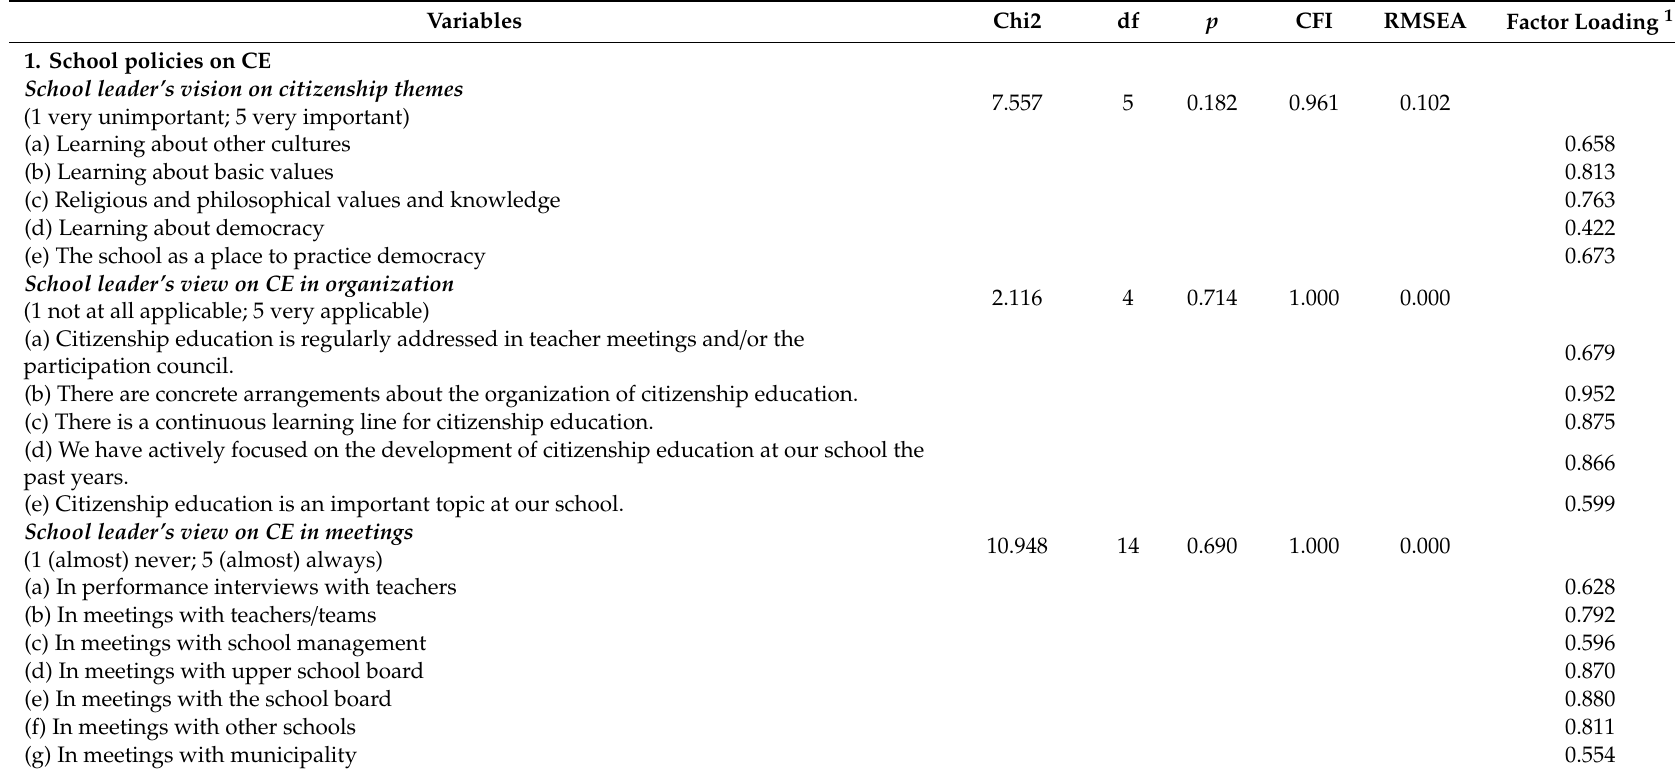
Table A3. Citizenship education factor scales: descriptive statistics at the item